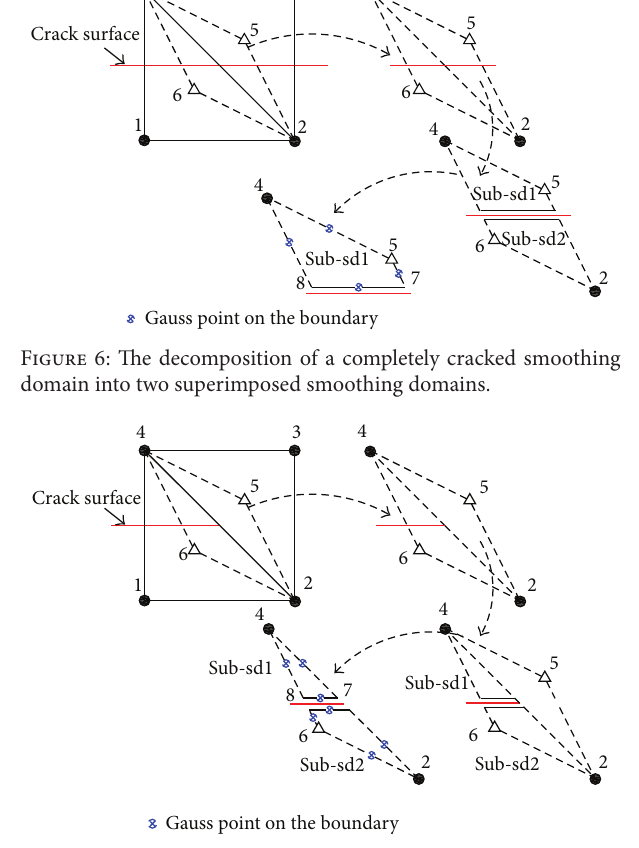
Figure 7: The decomposition of a cracked smoothing domain containing crack tip into two superimposed smoothing domains.